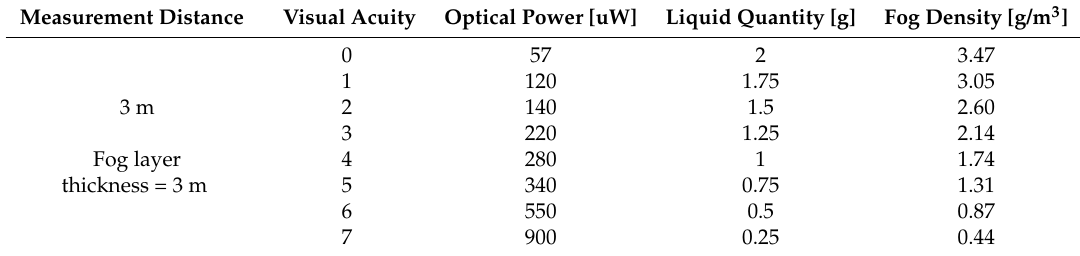
Table 5. Parallel between loss of optical power and visual acuity for different amounts of fog for uniform fog and observation of the 3 m